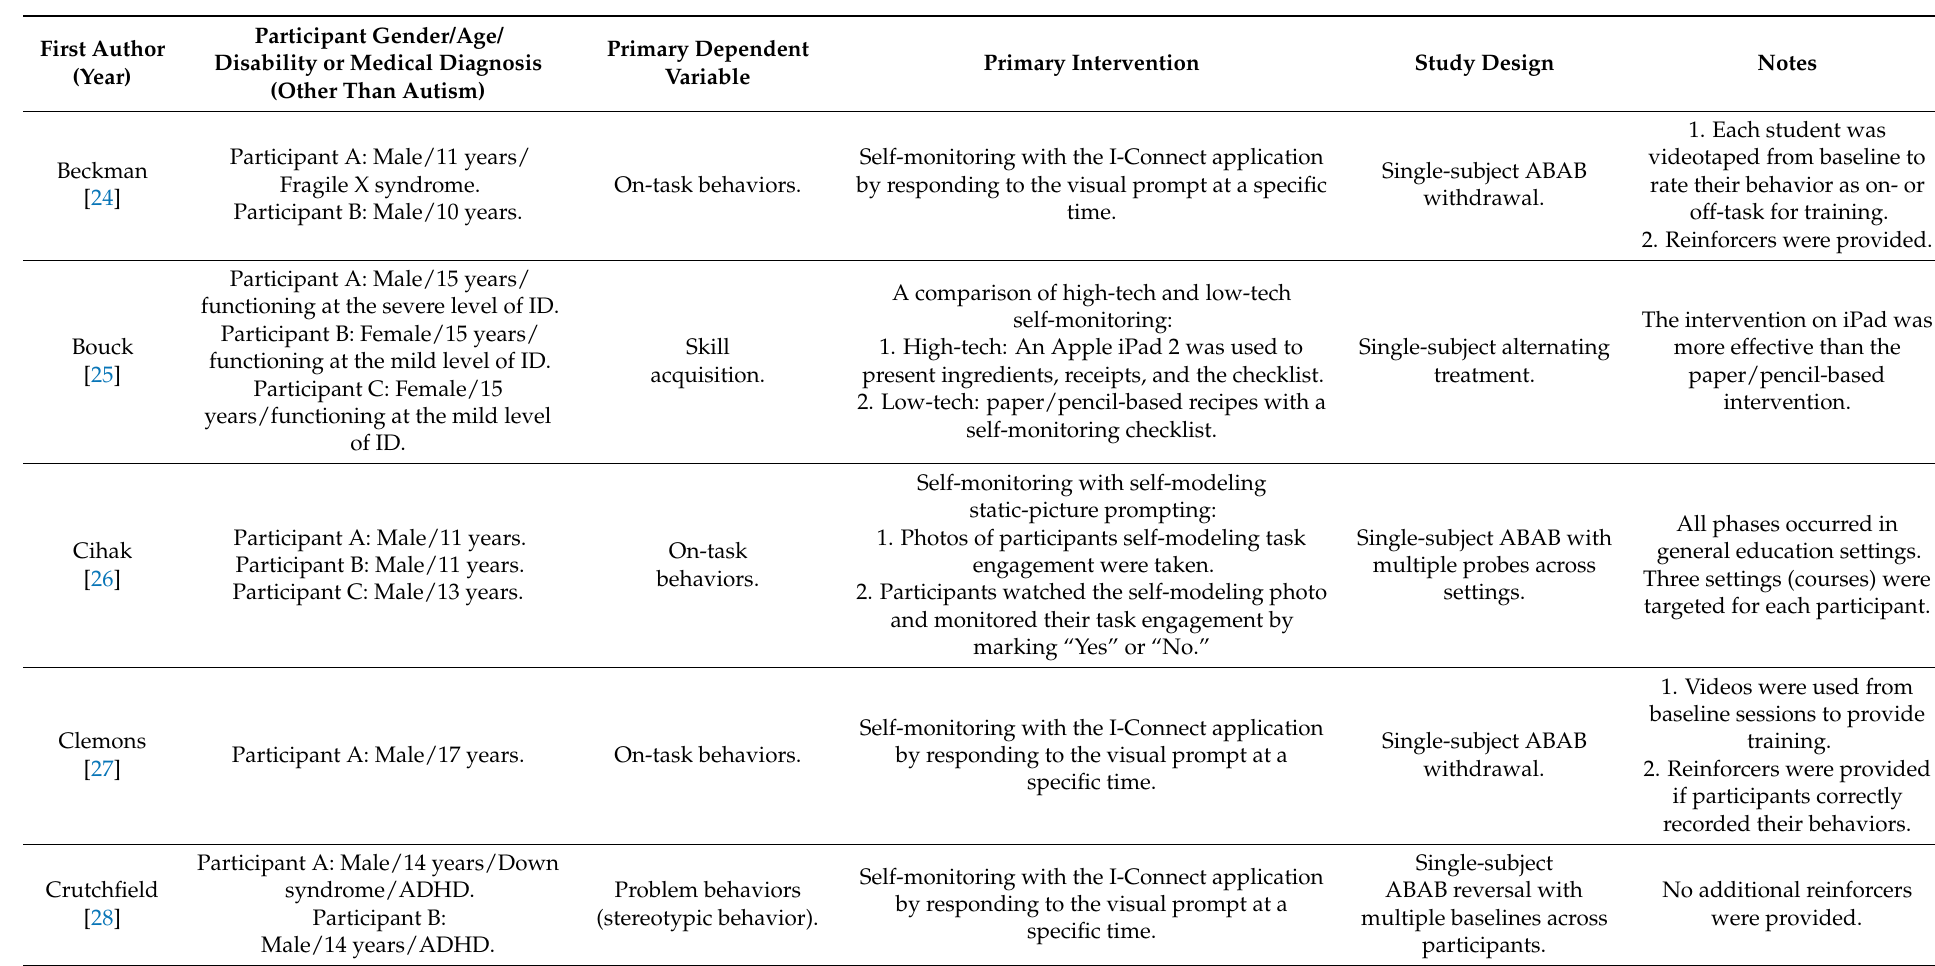
Table 1. Summary of Included